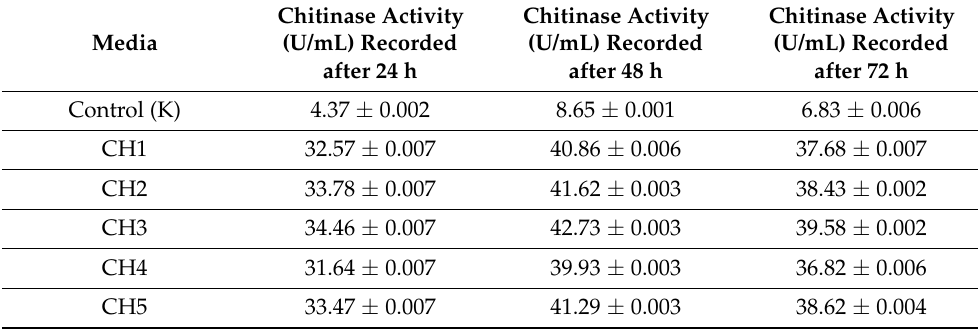
Table 5. Chitinase enzyme activity of Bacillus subtilis .